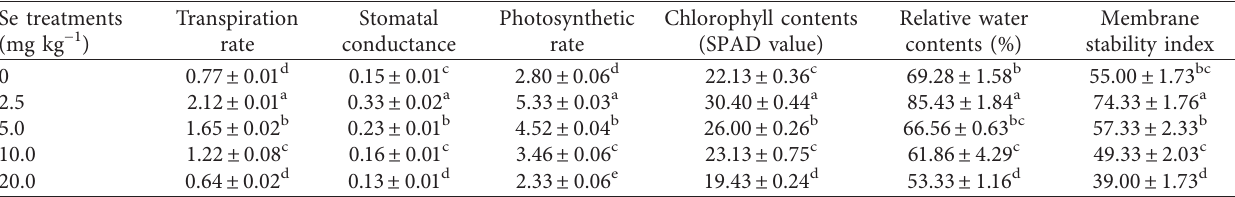
Table 3: Effect of different selenium levels on transpiration rate, stomatal conductance, photosynthetic rate, chlorophyll contents, relative water contents (%), and membrane stability index.